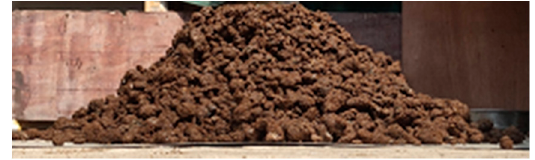
Figure 5. Image of accumulation body.